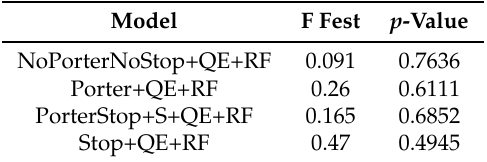
Table 30. T1: ANOVA test results for the indexes for P@10.